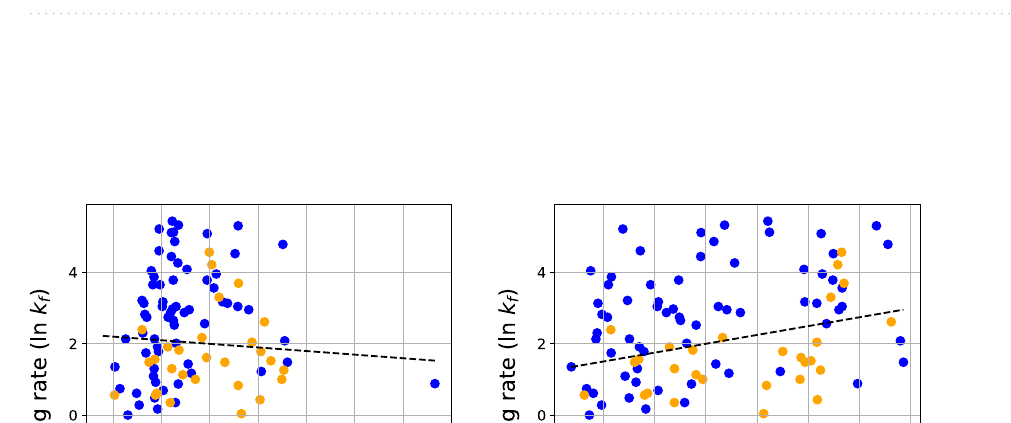
Figure 3. The plots on the diagonal show the distribution of each measure for the protein set. The scatter plots compare the measures pairwise for each protein. Blue points represent two-state and orange points represent multi-state proteins. We see that there is little correlation between Wr and v 2 , Wr and Av 2 , ACN and v 2 , or ACN and Av 2 . Wr and ACN show a correlation, as well as v 2 and Av 2 .